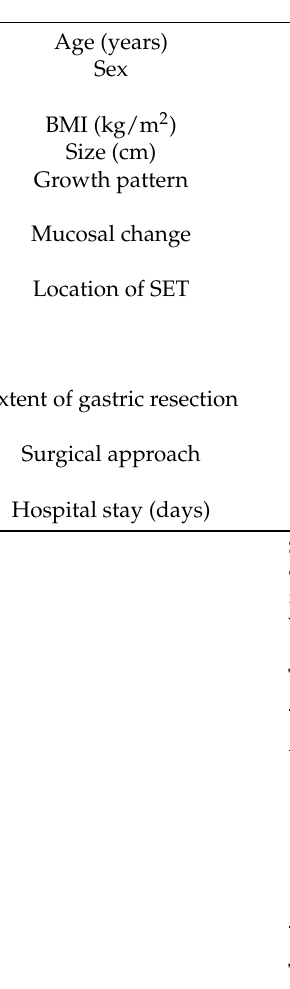
Table 4. Comparison of cardiac and non-cardiac